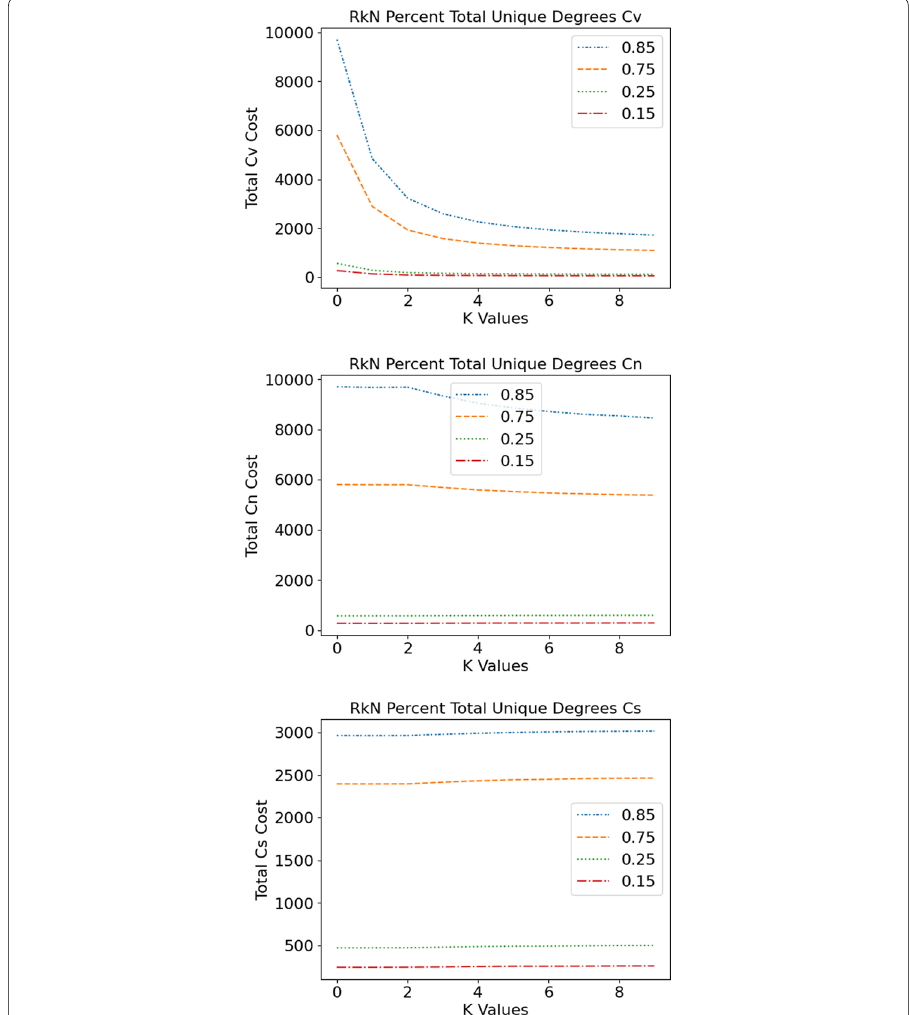
Fig. 8 Costs of selecting percents of all unique degrees in the graph with RkN sampling for varying values of